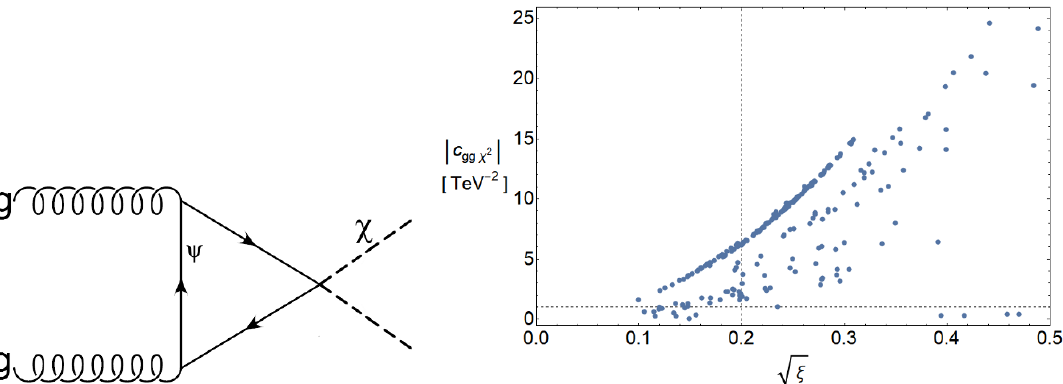
Figure 9 . Left panel: Feynman diagram for the main production channel of (cid:31) boson pairs in an hadron collider. (cid:9) is any fermion, elementary or composite, with mass m ( n ) . The amplitude of the depicted diagram is proportional to the coe(cid:14)cient c de(cid:12)ned in eq. (4.6). Right panel: absolute gg(cid:31) 2 p value of c as function of (cid:24) , for the BP. The dotted horizontal line is at 1 TeV (cid:0) 2 and the dotted gg(cid:31) 2 p vertical line is at (cid:24) = 0 :